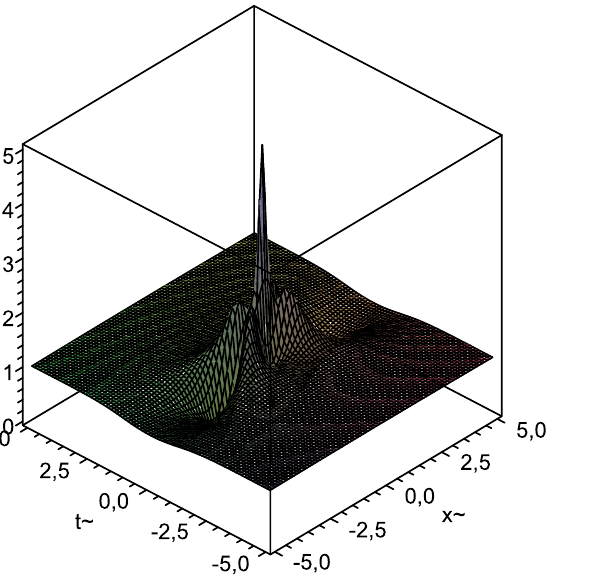
Fig. 3. Amplitude of the Peregrine breather of order 2.